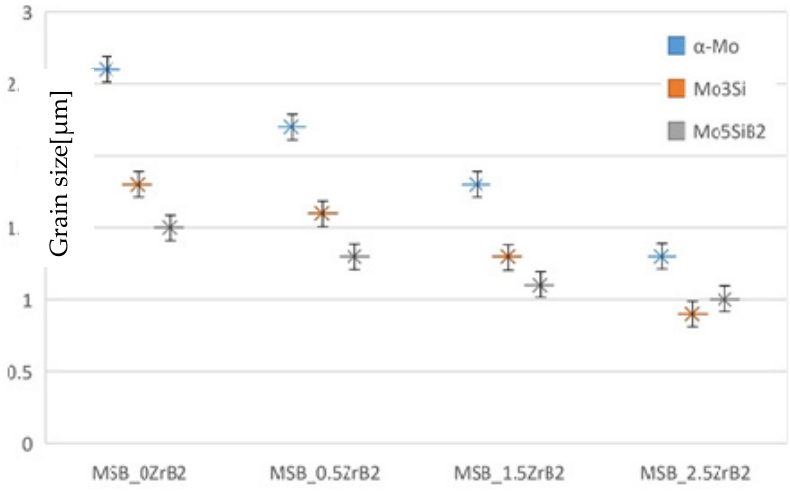
Figure 4. Grain size diagram of alloys with different Zr